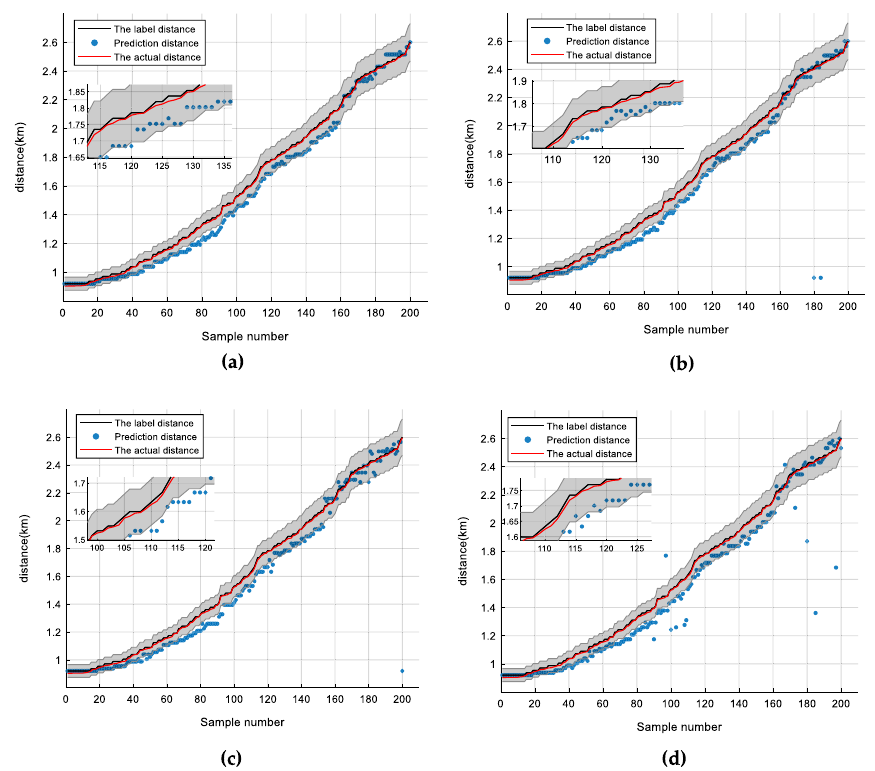
Fig. 11 Prediction results of acoustic source localization: a RA-CAE-SSL model; b CAE-SSL model; c RA- SL model; d CNN